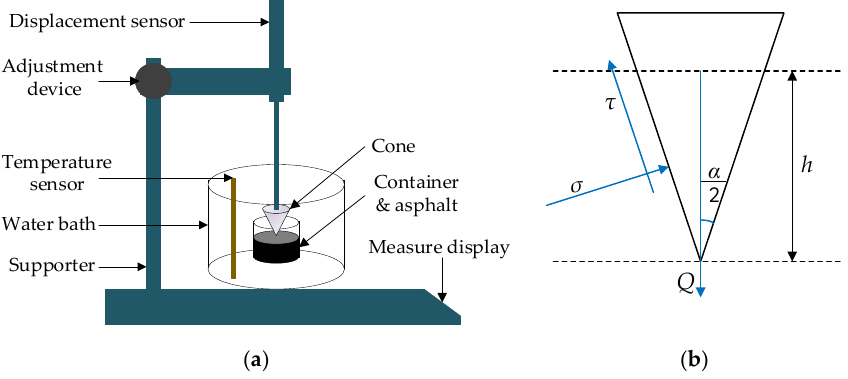
Figure 3. Cone penetration test [28]: ( a ) diagram of cone penetration test; ( b ) cone structure.